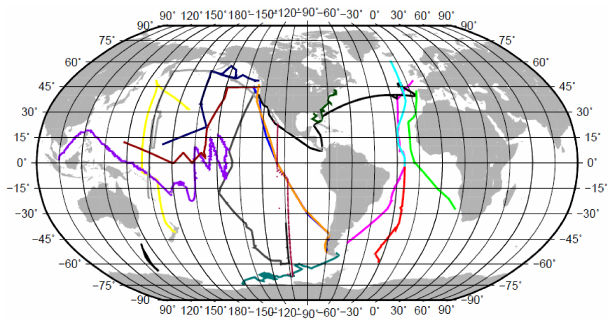
Figure 1. Research cruises contributing to this study: SAGA-2, Leg I (1987, W Pacific; yellow), RITS89 (1989, E Pacific; orange), SAGA-3 (1990, Equatorial Pacific; lime), OAXTC (1992 N. Pa- cific; light gray, part of WOCE P13), BLAST1 (1994, E Pacific; olive), BLAST2 (1994, Atlantic; cyan), BLAST3 (1996, Southern Ocean; dark gray), GasEx98 (1998, N. Atlantic, Gulf of Mexico, NE Pacific; pink), RB9906 (1999, NE Pacific; cyan), CLIVAR01 SR3 (2001, Southern Ocean; brown), A16N (2003, N Atlantic; dark green), A16S (2005, S Atlantic; red), PHASE (2004, Cen- tral and North Pacific; purple), P18 (2008, Tropical and SE Pacific; dark green), GOMECC, Coastal NW Atlantic; olive), HalocAST-P (2010, E Pacific; blue, underlying BLAST 1, HalocAST-A (2009, E Atlantic;